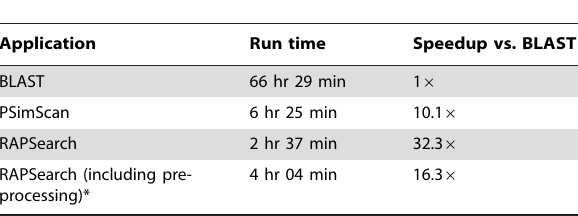
Table 1. Performance testing against NCBI nr database.